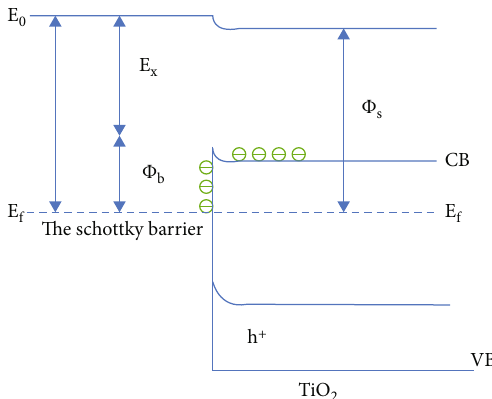
Figure 5: The schematic Schottky barrier. In the fi gure, Ef represents the Fermi level, VB represents valence band, CB stands for conduction band, h + denotes a hole. Φ b is the height of the Schottky barrier, and Φ s is the work function of titanium dioxide; E fi eld; E represents the surface x stands for built-in electric 0 potential energy of the precious